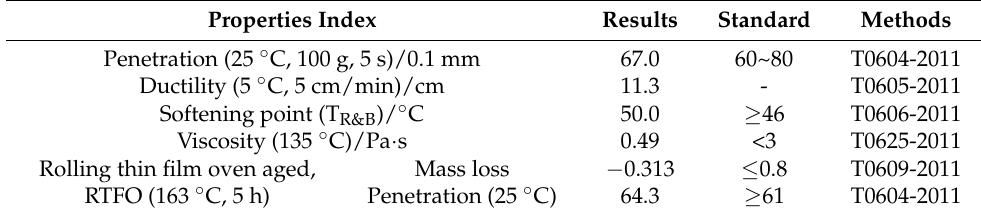
Table 1. Technical property index of 70# bitumen.